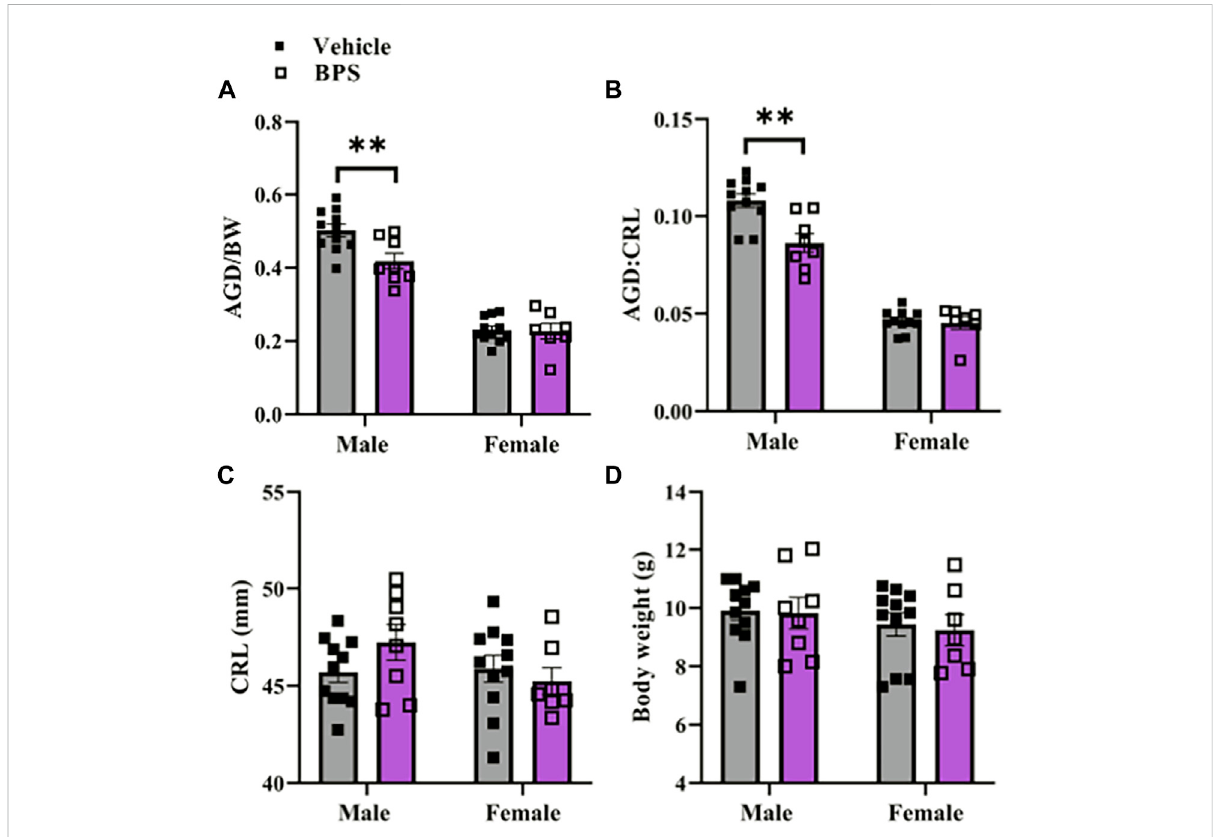
FIGURE 1 StuntedmasculinizationinmalepupsexposedtoBPS.Anogenitaldistancenormalizedto (A) bodyweightor (B) crown-to-rump-length(CRL)in Pd21maleandfemalemiceprenatallyexposedtovehicleorBPS. (C) Bodyweightand (D) CRLofmaleandfemalePd21mice.Eachsamplerepresents the average of the litter and differences were assessed by Student ’ s t-test. **, p < 0.01 BPS vs.